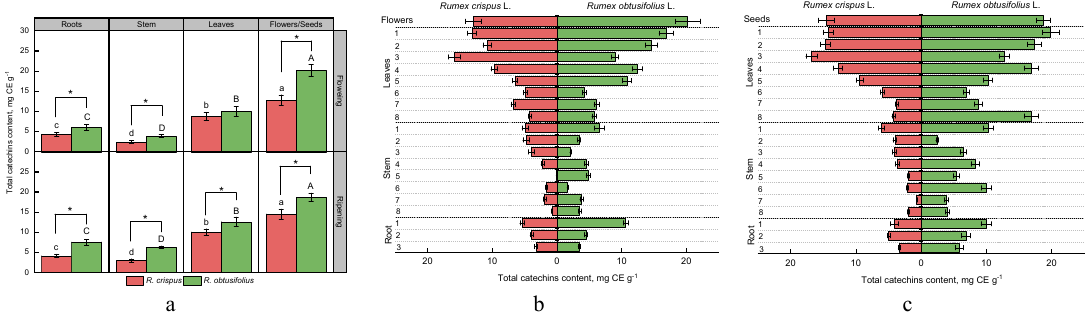
Figure 2. The content of catechins in different parts of plants R. crispus and R. obtusifolius at the stages of flowering and fruiting ( a ), and vertical distribution of catechins at flowering stage ( b ) and at fruiting stage ( c ). Different lower case letters indicate significant differences among plant parts of R. crispus ; upper case letters indicate significant differences among plant parts of R. obtusifolius ( p ≤ 0.05); and asterisk * indicates significant differences among sorrel species ( p ≤ 0.05) based on post hoc Tukey’s tests separately for each growth stage.